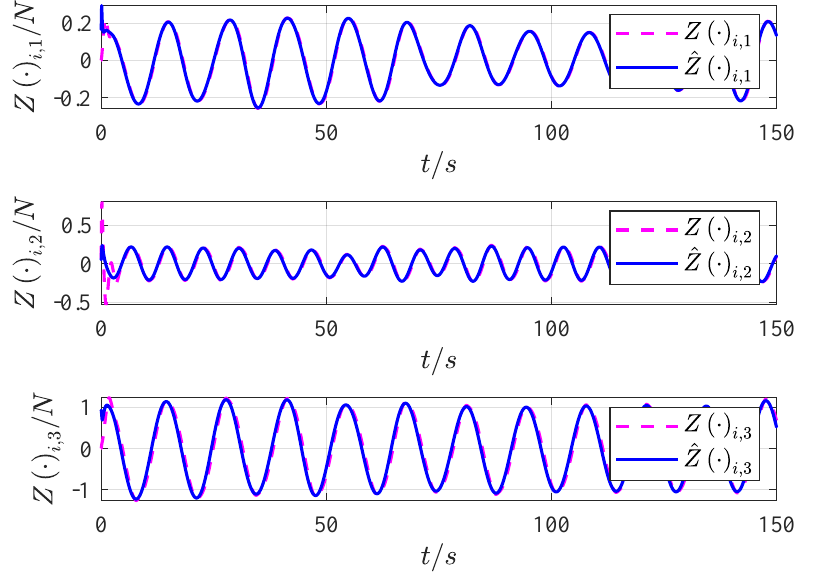
Figure 6. Observation results of